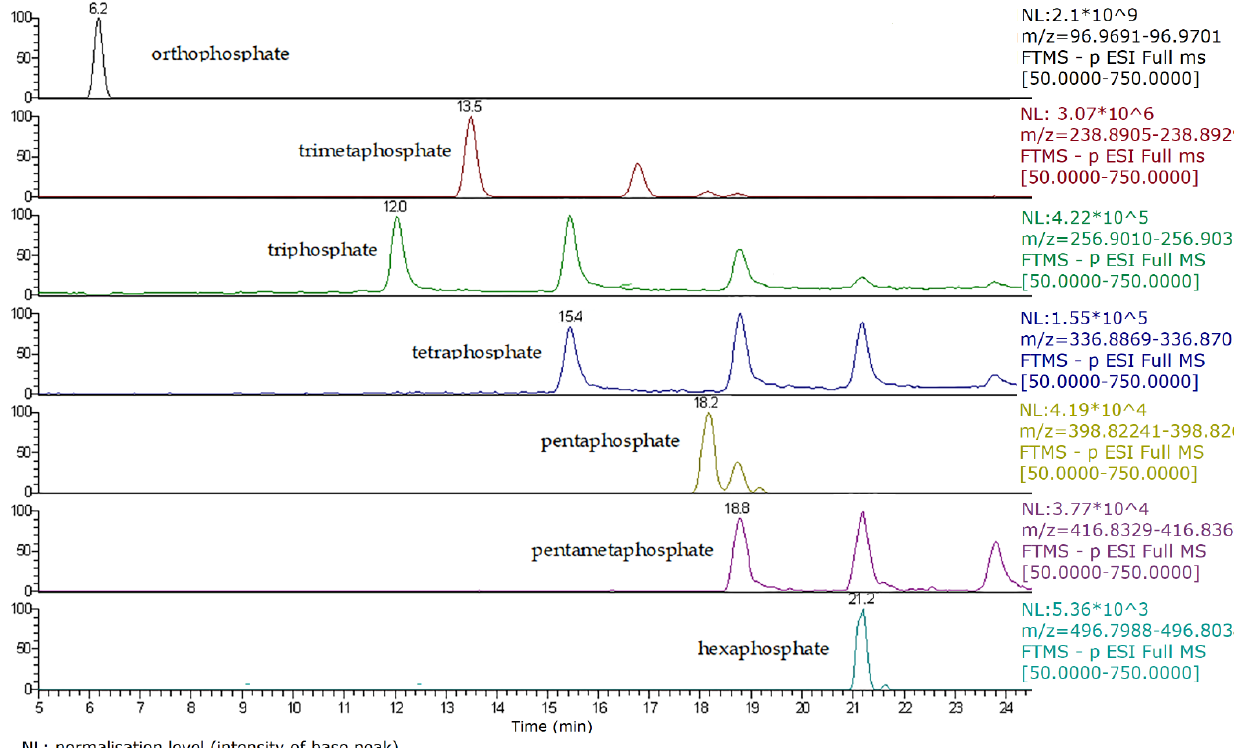
Figure 5. Q-Exactive Orbitrap HRMS total ion chromatogram of caramote prawn I with different (poly)phosphate anions detected. NL: normalisation level (intensity of base peak).